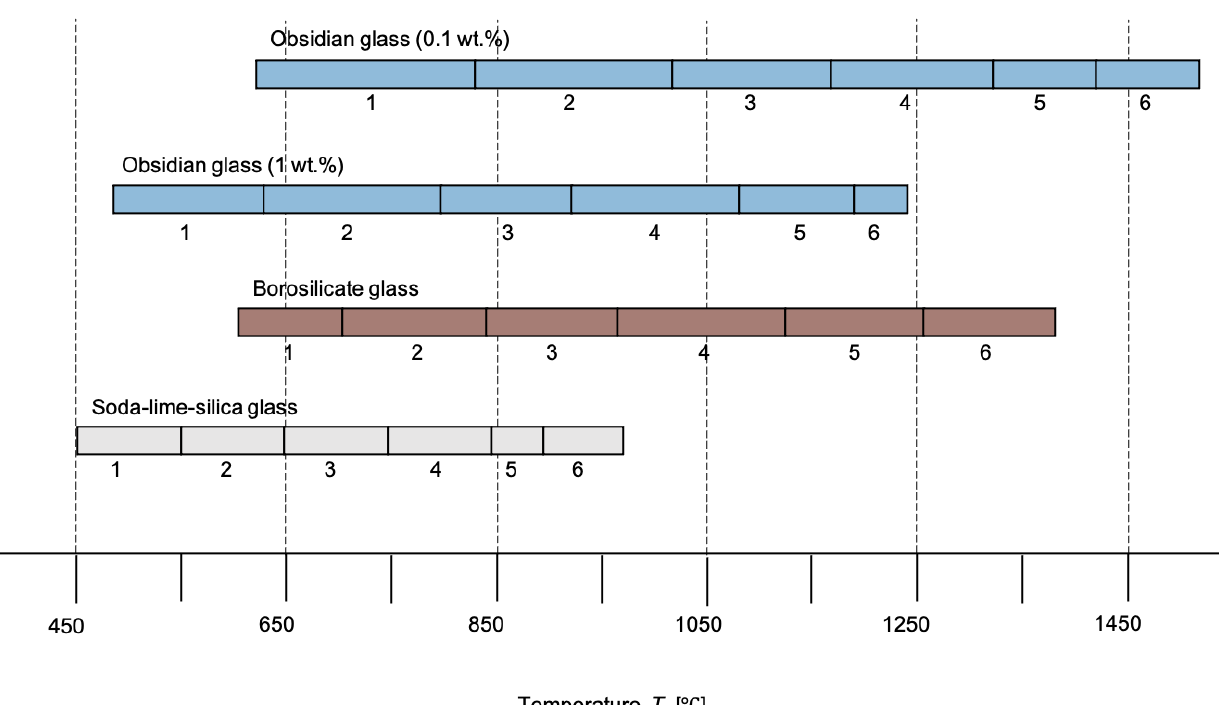
Figure 4: A summary of the working range of Cristalica® (grey), borosilicate (brown), and obsidian (blue) for each of the six processes described by Cummings [1997]: (1) enameling and lustreing; (2) bending; (3) stretching; (4) fusing; (5) casting (inert); (6) casting (mobile). The value 1.0 wt.% and 0.1 wt.% for the obsidian refer to the dissolved water concentration remnant in the glass at the time of working, such that the 0.1 wt.% obsidian